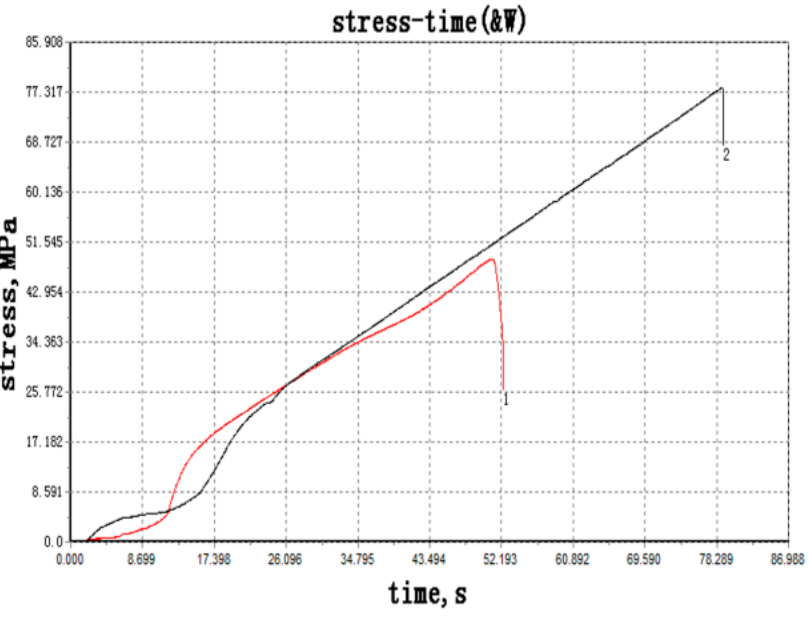
Figure 3. Shear curves of different rolling processes: ( 1 ) unpulsed; ( 2 ) pulse.